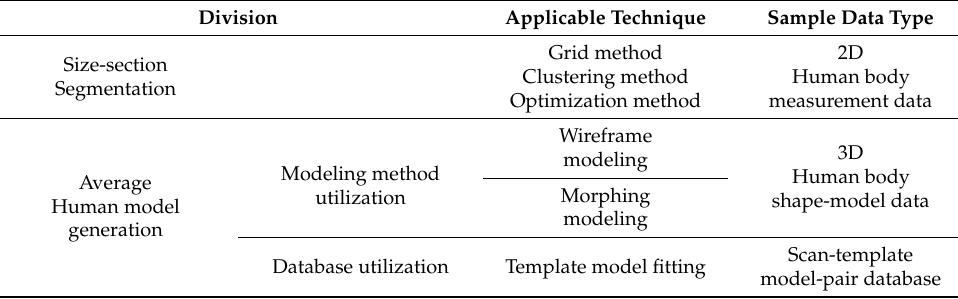
Table 1. Analysis of size-system generation method.